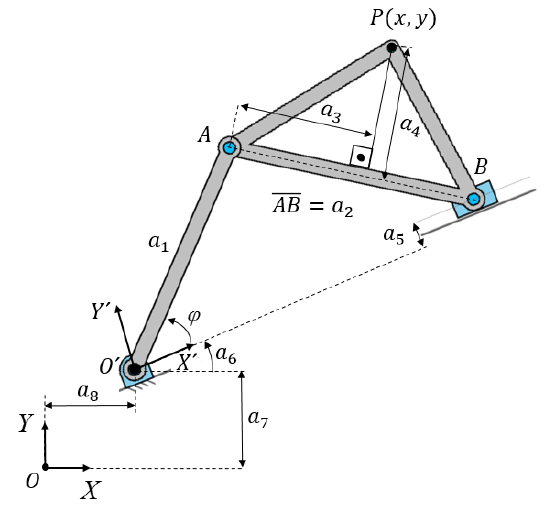
Figure 3. Slider-crank mechanism with 8 dimensional parameters.